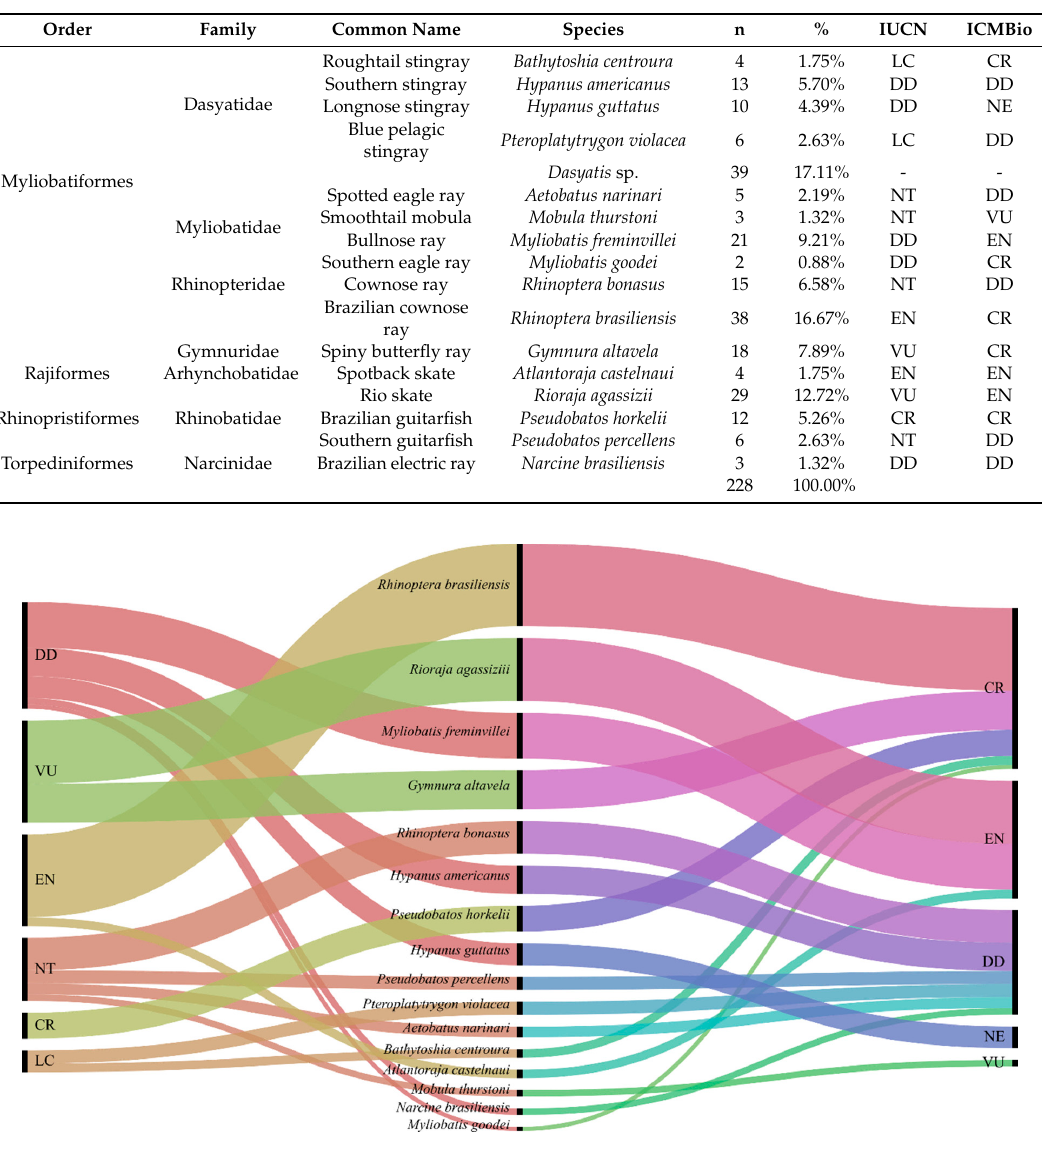
Figure 2. Alluvial diagrams allow to represent the correlation between the identified batoid species and their conservation status on the International Union for Conservation of Nature (IUCN) Red List and the Brazilian Red List. The left side of the chart shows the correlations between the identified batoid species and the IUCN Red List status; the right side shows the correlation between the identified batoids species and the Brazilian Red List. The chart was built using the online tool RAWGraphs (https://rawgraphs.io/).